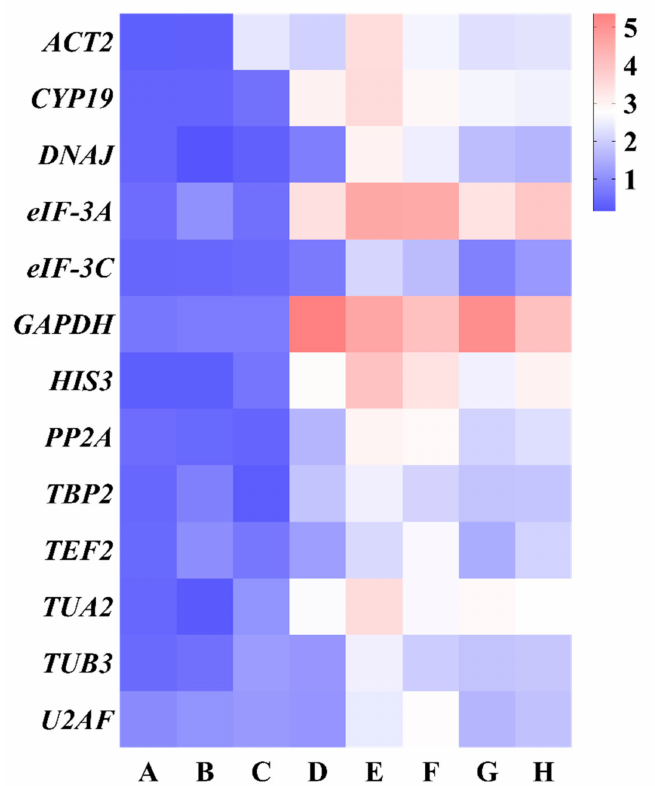
Figure 6. Expression stability of candidate reference genes calculated by BestKeeper. ( A ) Di ff erent genotypes, ( B ) di ff erent developmental stages, ( C ) di ff erent tissues, ( D ) salt stress, ( E ) heat stress, ( F ) cold stress, ( G ) osmotic stress, and ( H ) all samples. Low to high expression stability is represented over a spectrum from red to blue,